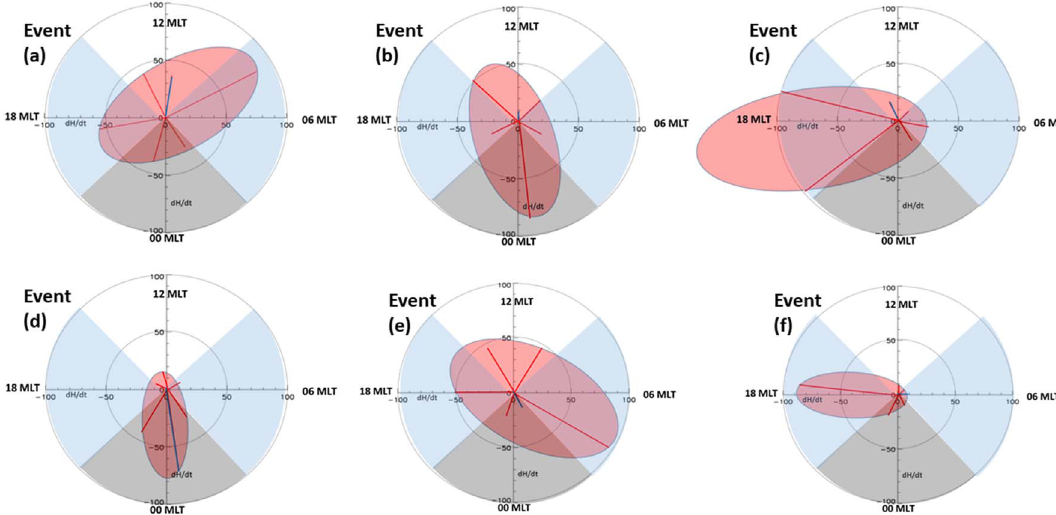
Fig. 5. Clock plots of d H /d t for the fi rst (upper row, events (a) – (c)) and second intervals (lower row, events (d) – (f)), indicating the MLT orientation of maximum variation. Red lines indicate the d H /d t for each event observed at northern hemisphere sites, and blue for the New Zealand site. Approximate MLT zones of extreme d H /d t associated with DP1 and DP2 current systems (Freeman et al., 2019) are shown by dark and light grey shading